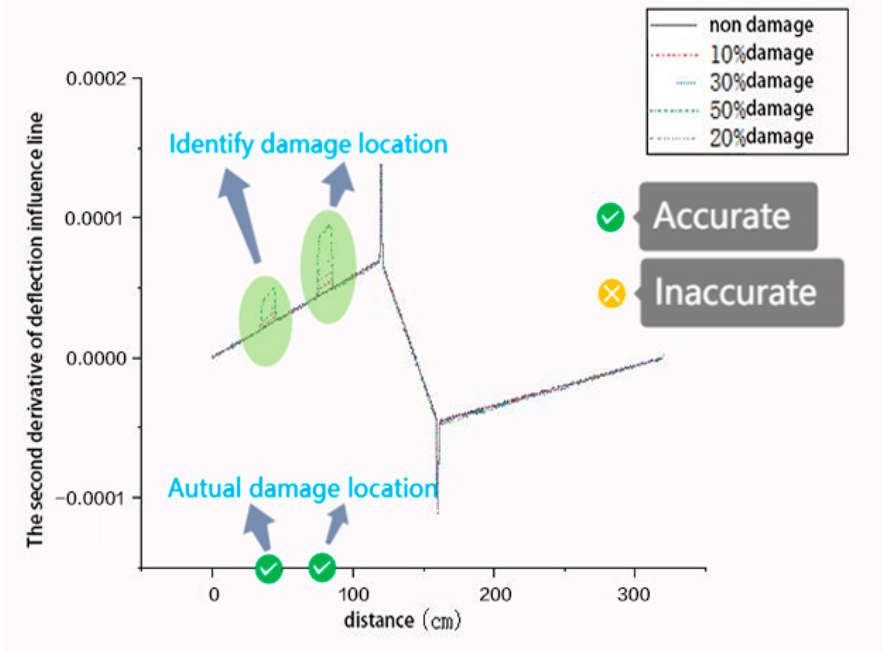
Figure 15. The 2nd derivative of deflection influence line at 3/4 determining point of the 1st span under work condition 2 (2-5).